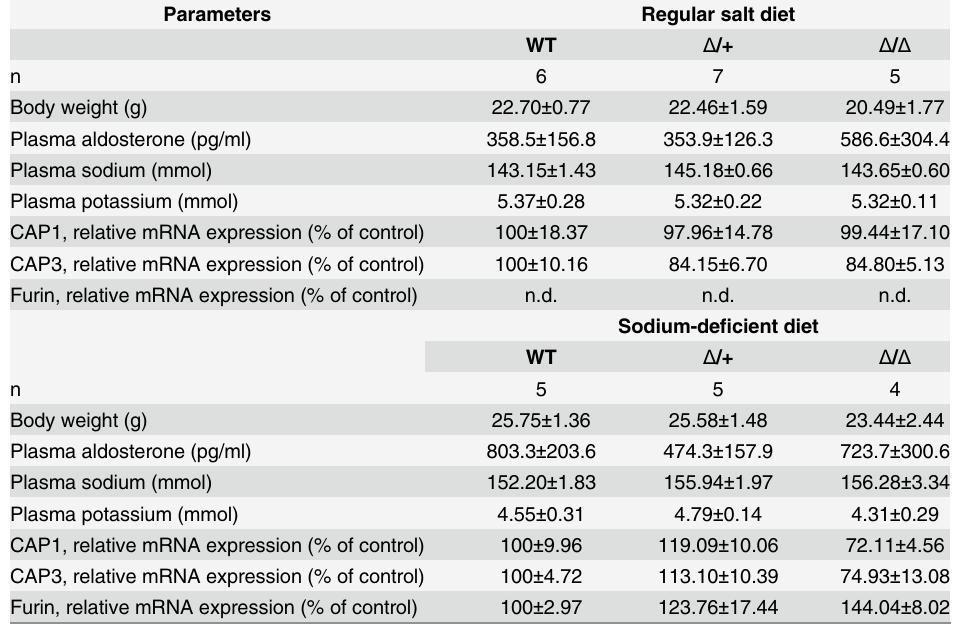
Table 1. Physiological parameters under regular salt diet or sodium-deficient